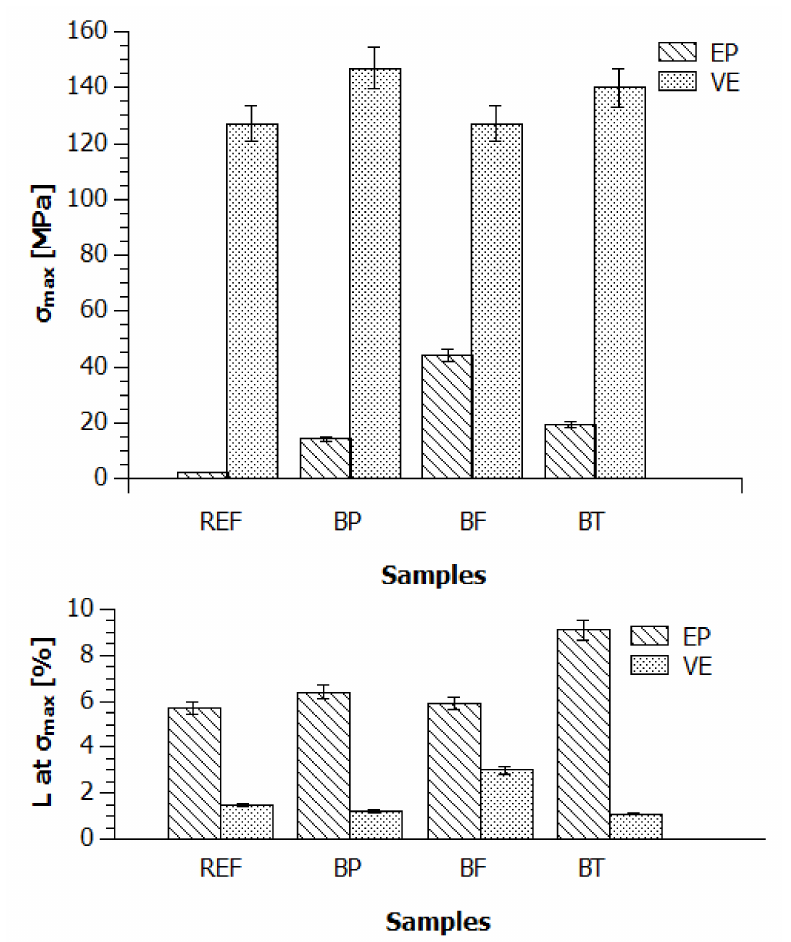
Figure 12. Diagrams of σ max and corresponding elongation (L at σ max ) in bending strength test for composites EP and VE reinforced with basalt powder (BP), basalt fibre (BF) and basalt textile (BT) for measurements carried out at 80 ◦